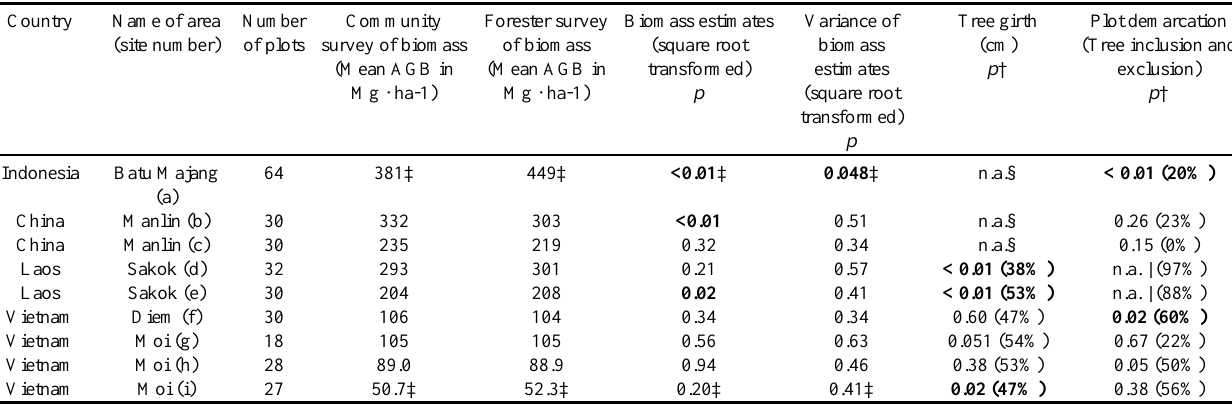
Table 1 . Measurements of aboveground biomass (AGB) by local community members and professional foresters in four Southeast Asian countries, with p values for total biomass estimates (matched pair t test) and variance ( F test), tree girth measurement (Wilcoxon signed rank test), and plot demarcation (Wilcoxon signed rank test) ( n = 289 permanent plots). Significant values are shown in bold (n.a. = not available).